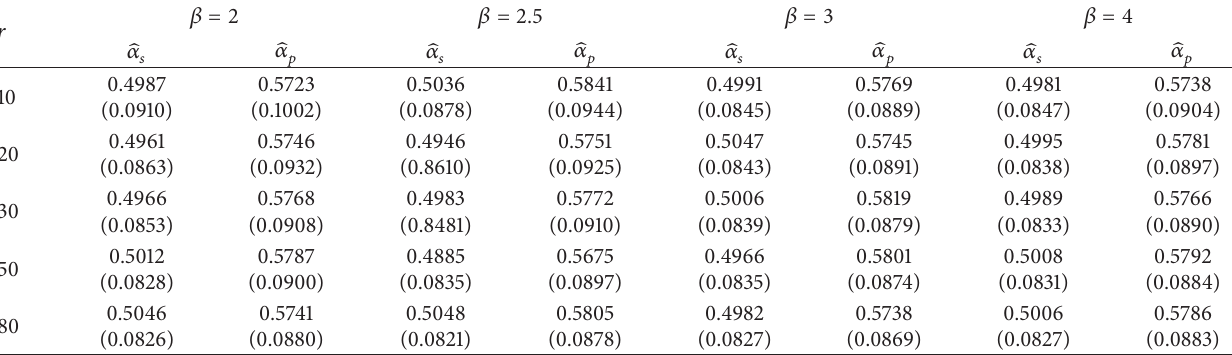
Table 2: Mean (MSEs) of the different estimators for 𝛼